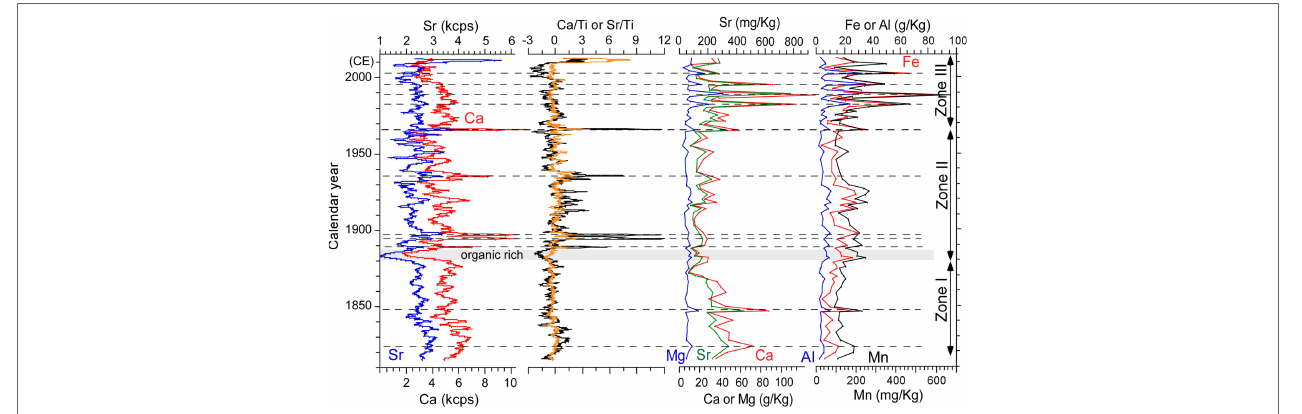
FIGURE 6 | Comparison of the variations in elemental contents measured by XRF scanning and ICP-OES methods in Core SBB-8-2012. Note that elemental concentration has different units, being g/Kg for Fe, Mg and Ca, and mg/Kg for Mn and Sr. The horizontal dashed lines show the comparisons when the acid- leachable elemental concentrations were relatively